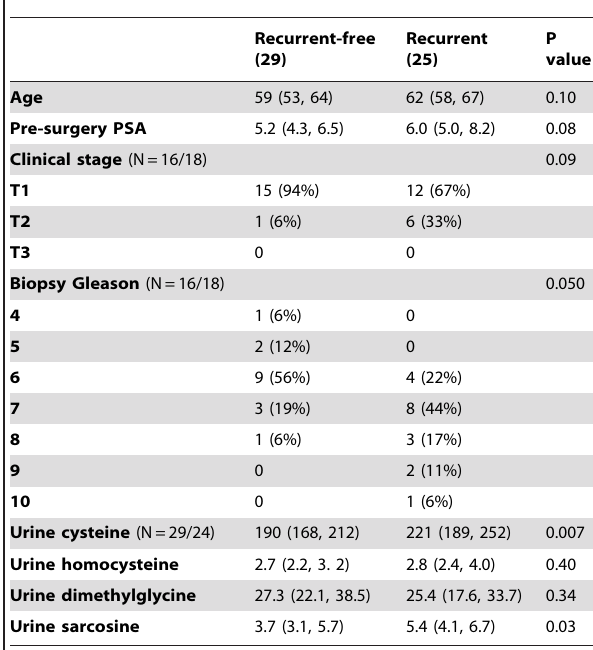
Table 1. The values for methionine metabolites measured